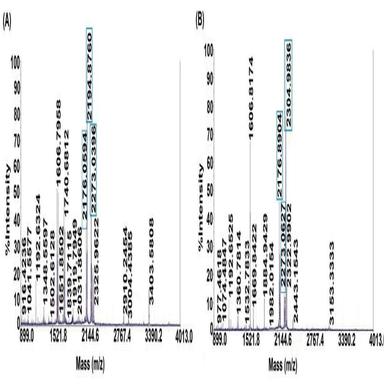
Detection and molecular localization of AGEs in Mb modified with MG for 14 and 21 days. Tryptic mass spectra of Mb modified with MG for 14 days (A) and 21 days (B), respectively. The MG-modified peaks are marked in each spectrum.